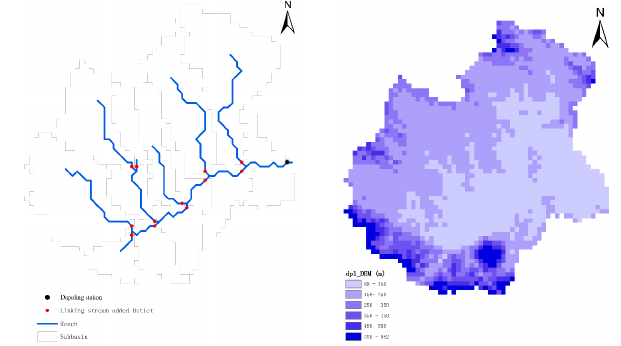
Figure 1. Sketch map and DEM of the upper Huaihe River above the Dapoling station.